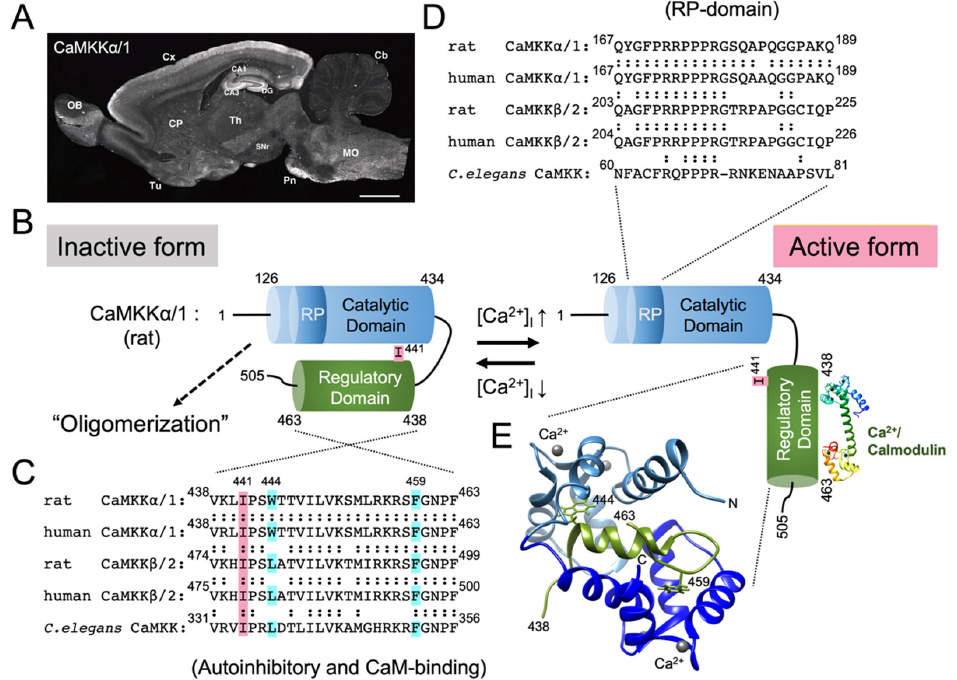
Figure 1. CaMKK α /1; activation mechanism, immunohistochemical localization in the rat brain, and Ca 2+ /CaM-binding. ( A ) Sagittal section of the adult rat brain immunostained with a monoclonal antibody against CaMKK α /1 (reproduced from Ref. [61], with permission from John Wiley and Sons). CA1 and CA3, CA1 and CA3 subregions of Ammon’s horn of the hippocampus; Cb, cerebellar cortex; CP, caudate putamen; Cx, cerebral cortex; DG, dentate gyrus; MO, medulla oblongata; OB, olfactory bulb; Pn, pontine nuclei; SNr, substantia nigra pars reticulata; Th, thalamus; and Tu, olfactory tubercle. Scale bar = 2.5 mm. ( B ) Proposed model of CaMKK α /1 activation mechanism. At low intracellular Ca 2+ concentration, CaMKK α /1 is in an inactive conformation, where the catalytic domain (residues 126 − 434) is tightly associated with the regulatory domain (residues 438 − 463, C ). With increasing intracellular Ca 2+ concentration, Ca 2+ / CaM binds to regulatory domain of CaMKK α /1 (E) to suppress autoinhibition, thereby activating the kinase [64]. An activated CaMKK recognizes and phosphorylates downstream kinases including CaMKI, IV, and AMPK by using an Arg/Pro rich insert domain (RP-domain, D ) [39,65]. Amino acid sequence alignments of the regulatory domain including the autoinhibitory and Ca 2+ /CaM binding segments ( C ) and RP-domain ( D ) in various CaMKKs (rat, human α /1 and β /2 isoforms, and C. elegans ). Trp(W)444 and Phe(F)459 in rat CaMKK α /1 ( C ) are conserved anchoring residues (indicated by light blue boxes) to the N- and C-terminal hydrophobic pockets of Ca 2+ /CaM, respectively [66]. Ile(I)441 (indicated by a pink box, C ) is important for rat CaMKK α /1 autoinhibition [64]. ( E ) Ribbon diagram of the NMR structure of Ca 2+ /CaM-CaMKK α /1 regulatory domain peptide (residues 438 − 463, C ) complex was obtained from the Protein Data Bank (PDB) entry 1ckk [66] and was visualized using the UCF Chimera [67]. Modified from Ref. [68].